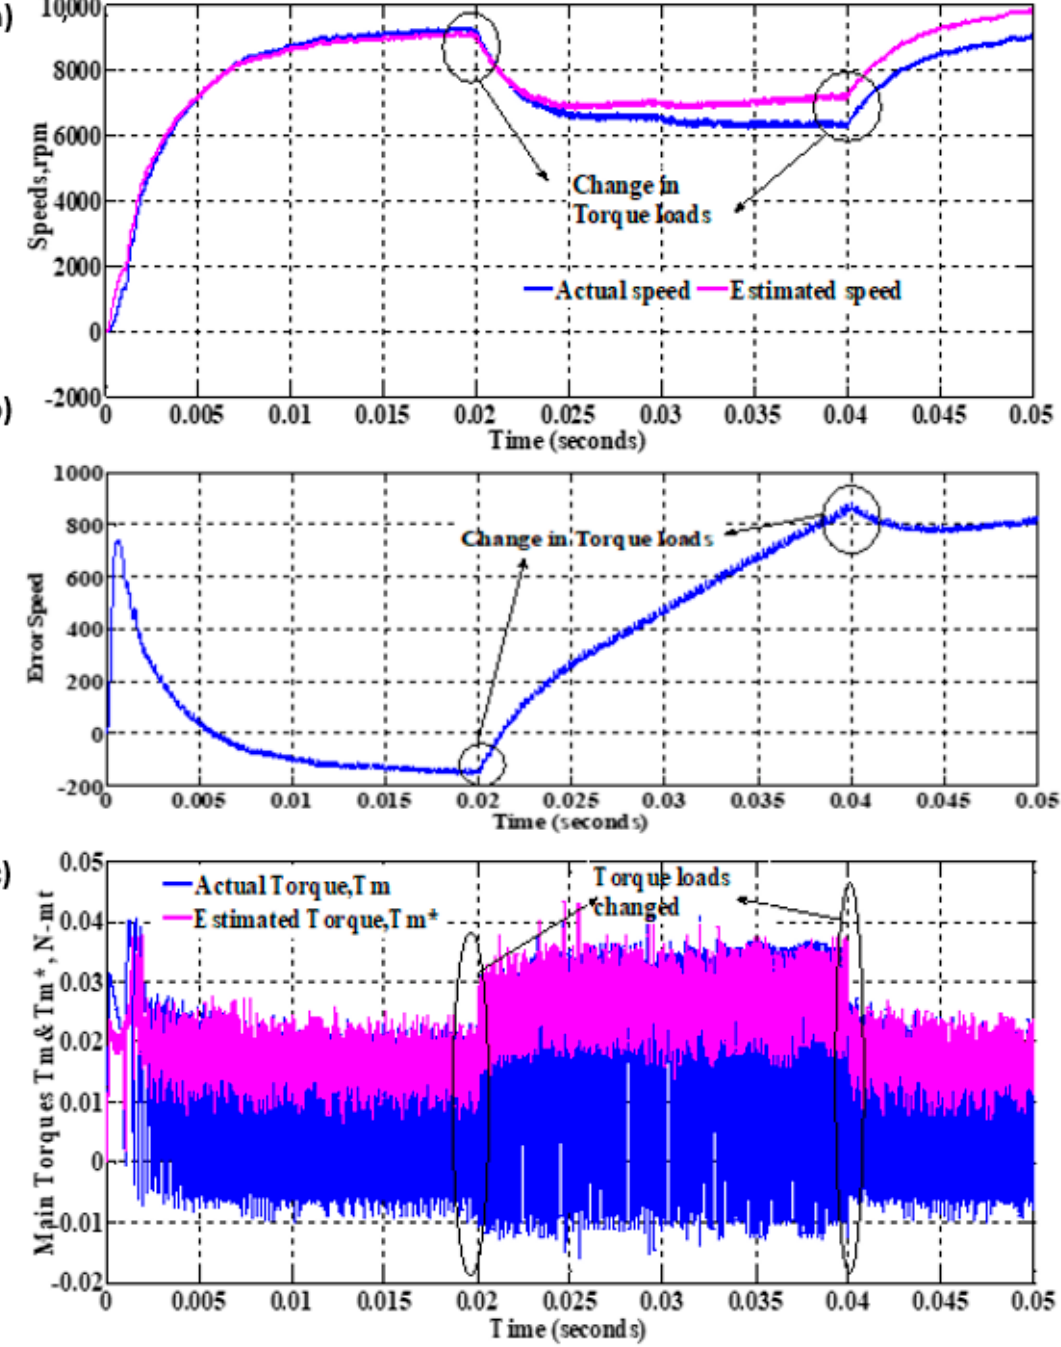
Figure 19. ( a ) Estimated and actual speeds, ( b ) speed tracking error, and ( c ) estimated and actual net torque values when load torques